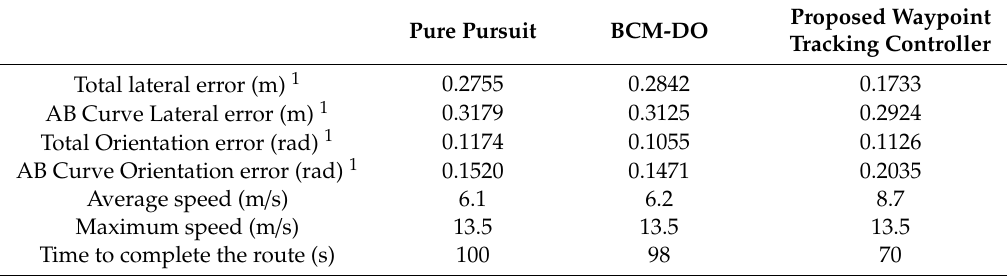
Figure 12. Comparison with other tracking controllers: Pure Pursuit (magenta dashed line), Beam Curvature Method that deals with dynamic obstacles (BCM-DO) (red dot-dashed line), proposed Waypoint Tracking Controller (blue continuous line). Table 3. Comparison with other tracking